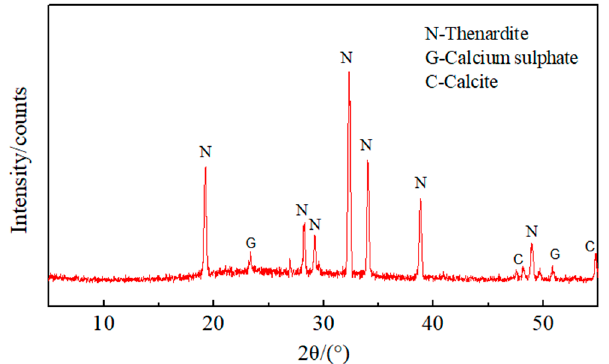
Figure 3. X-ray diffraction (XRD) diagram of white particles on the surface of QP20 sample. After 300 sulfate dry–wet cycles.